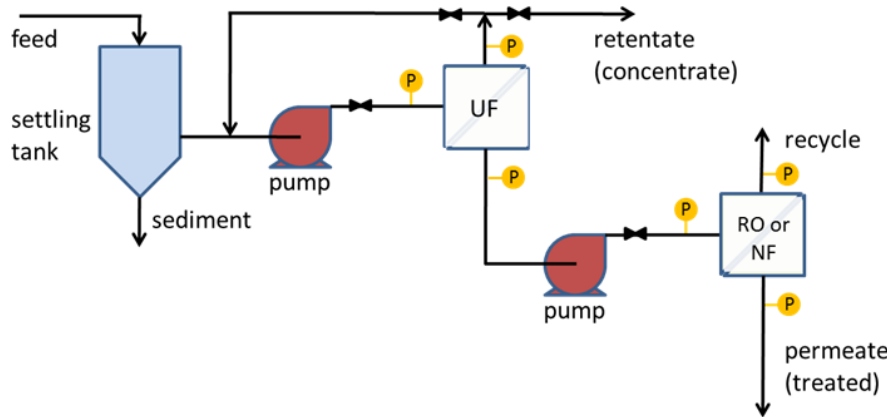
Figure 1. Two-stage membrane treatment process for rendering facility wastewater. The first stage uses membrane UF. This paper provides performance and economic data for the second “polishing” stage using RO or NF. P represents a pressure gauge.